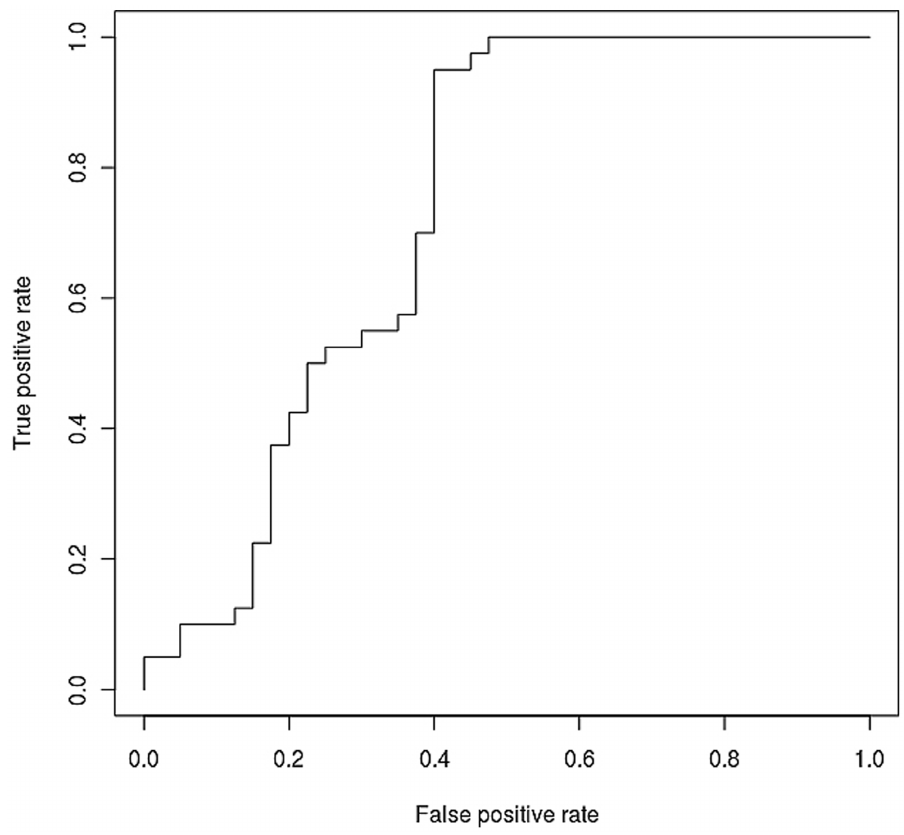
Figure 2. ROC curve of plasma eosinophil-derived neurotoxin.